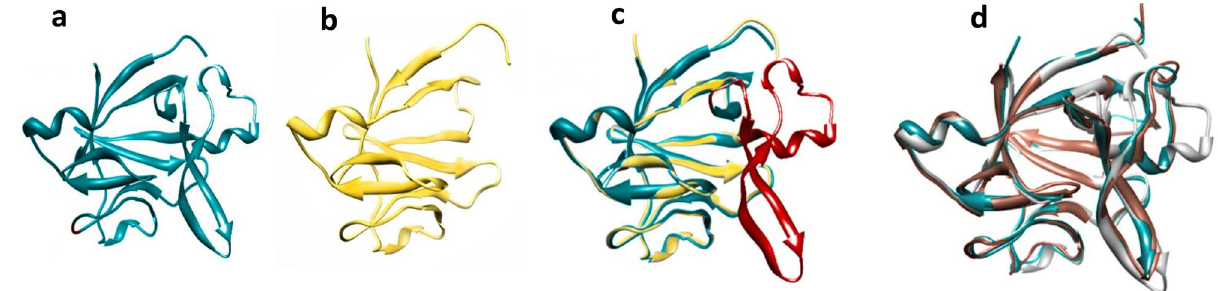
Figure 2. 3D structure of IL-1 ligands. ( a ) 3D structure of IL-1RA in comparison with T-IL-1RA model ( b ). ( c ) Superimposition of IL-1RA and T-IL-1RA (superimposed RMSD 0.407 Å). ( d ) Superimposition of IL-1RA (blue ribbon), IL-1β (pink ribbon), and EBI-005 (white ribbon) (superimposed RMSD 0.407